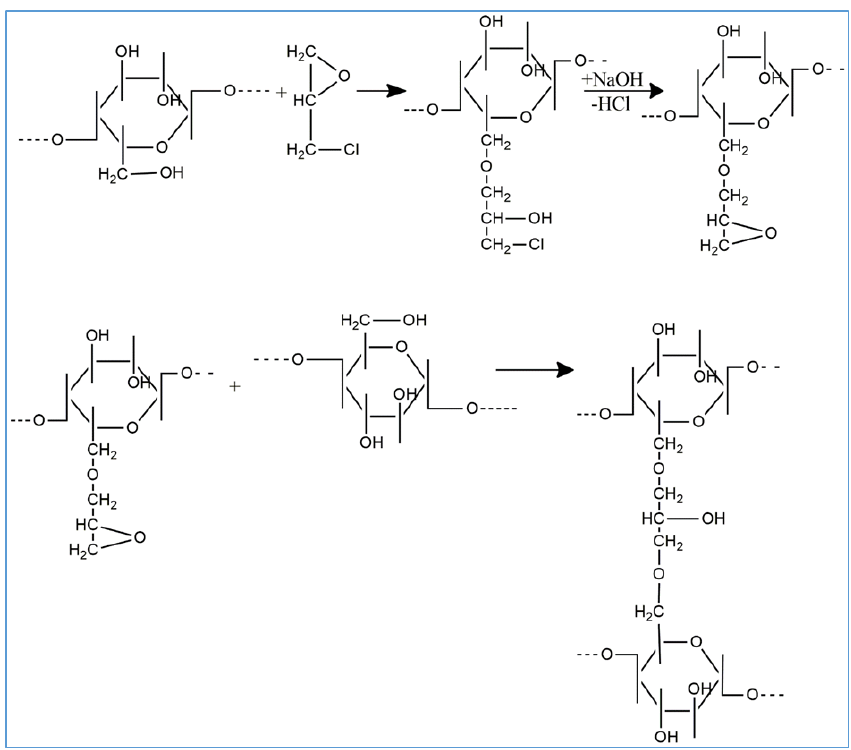
Figure 2. Schematic representation of cellulose crosslinking by ECH. Four different amounts of epichlorohydrin (ECH) were added to cellulose solution of the same weight (50 g), to obtain different weight ratios of the crosslinking agent to cellulose (1%, 7%, 10% and 15%). The obtained solutions were then stirred magnetically for 48 h to obtain the gel. The gel was washed several times with distilled water to remove all the NaOH traces and the excess ECH, until pH values of washing waters were constant. After filtration, hydrogels were put into cylindrical Teflon molds and heated for 24 h, at a temperature of 80 °C, to remove all the water [38]. After drying, opaque hydrogels in disk shape, with a diameter of 18 mm and a thickness of 0.2 mm, were obtained. Then, the hydrogels (approximately 0.2 g) were immersed in a beaker containing 2 g of crosslinking solution, composed of weight fractions of 99.4% HEMA monomer, 0.1% HDDA as crosslinker and 0.5% Darocur as photoinitiator, at room temperature. The hy- drogels were left in the solution until the swollen equilibrium was reached. Then, they were removed, wiped on their surface with filter paper and, finally, were put under UV radiation for 1 h. Thus, the HEMA monomers were crosslinked by photo-polymerization, in the presence of cellulose network. Figure 3 schematically represents the photochemically initiated crosslinking reaction of HEMA by radical copolymerization with HDDA.